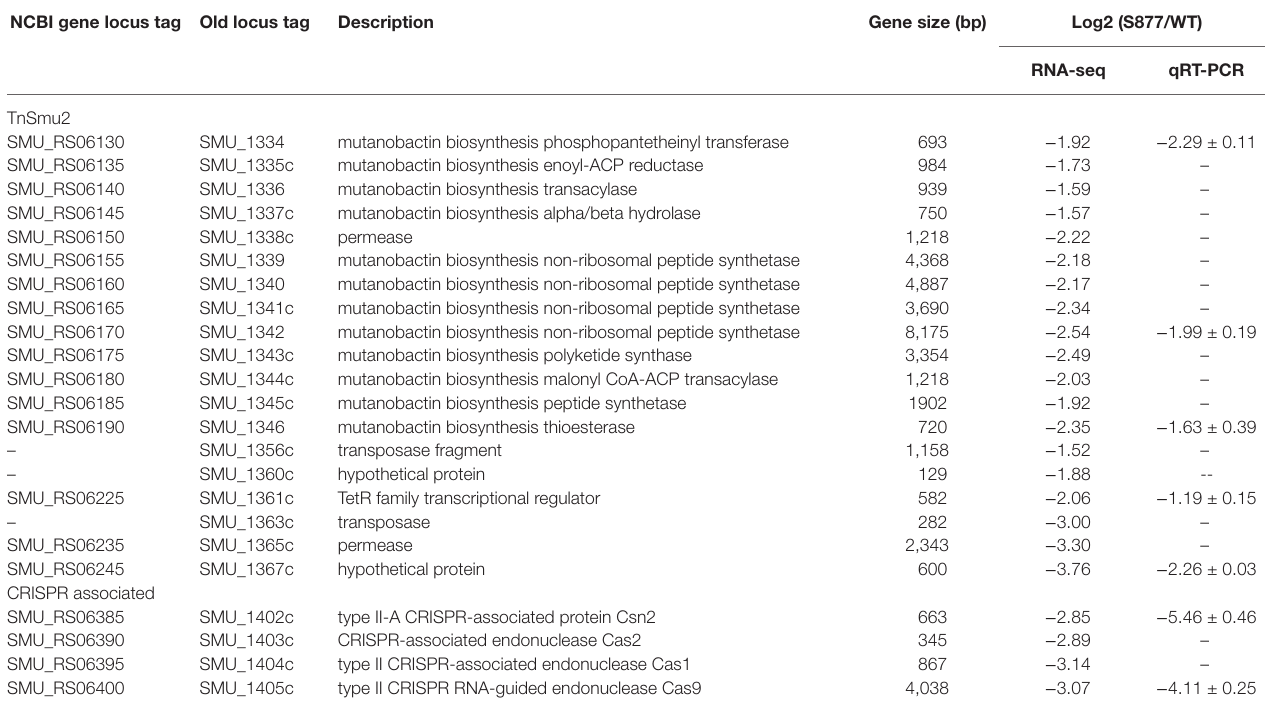
TABLE 2 | Differentially expressed genes in Streptococcus mutans strain S877. NCBI gene locus tag Old locus